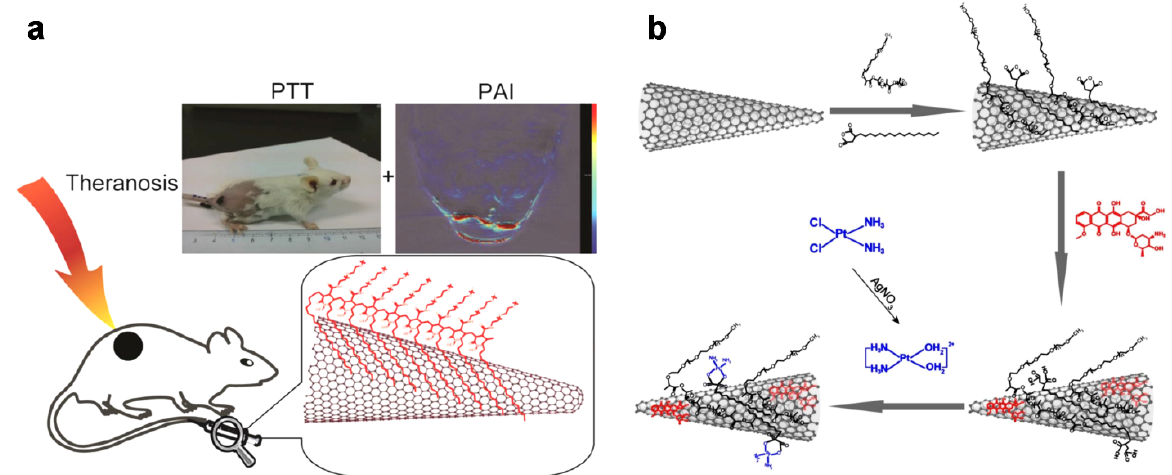
Figure 4. ( a ) Scheme to illustrate near-infrared photothermal therapy and photoacoustic imaging with SWNHs/C 18 PMH- PEG. Reproduced with permission from [74]. Copyright, John Wiley and Sons (2014). ( b ) Schematic illustration of the preparation of dual drug-loaded SWNHs. Reproduced with permission from [75]. Copyright, Ivyspring International Publisher (2018).